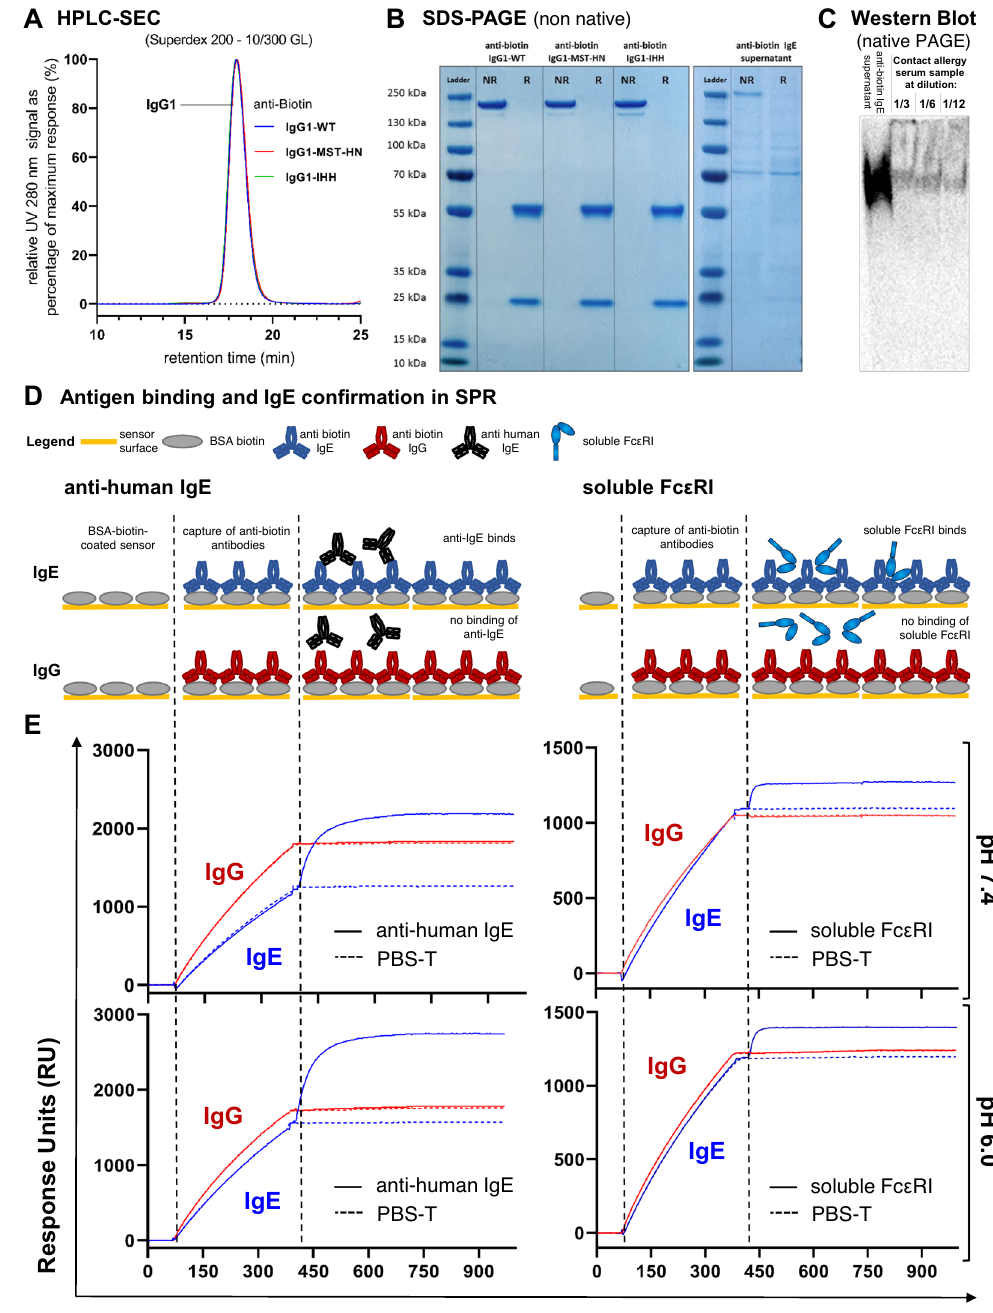
Figure 1. Confirmation of antibody integrity and antigen binding in SPR. ( A ) HPLC-SEC chromatograms of the IgG variants as relative UV280 nm signal normalized to maximum response. The chromatograms of molecules overlap. ( B ) SDS-PAGEs under non-reducing ( NR ) and reducing ( R ) conditions. Shown are two independently prepared SDS-PAGEs of purified V-gene matched IgG variants (left) and the IgE supernatant (right). The uncropped original images showing the relevant gel parts can be found in Supplementary Fig. 1A and B, respectively. ( C ) IgE-specific Western Blot after native PAGE of anti-biotin IgE supernatant next to contact allergy serum sample 32 . The uncropped original image showing the relevant lanes can be found in Supplementary Fig. 1C. ( D ) Schematic overview of SPR experiments showing anti-biotin antigen binding and presence of human IgE in culture supernatants. ( E ) Sensorgrams of one representative of three independent experiments showing binding of anti-IgE antibody (left) and soluble FcεRI (right) at pH 7.4 and pH 6.0 after capturing anti-biotin IgE from culture supernatant in comparison to IgG at 100